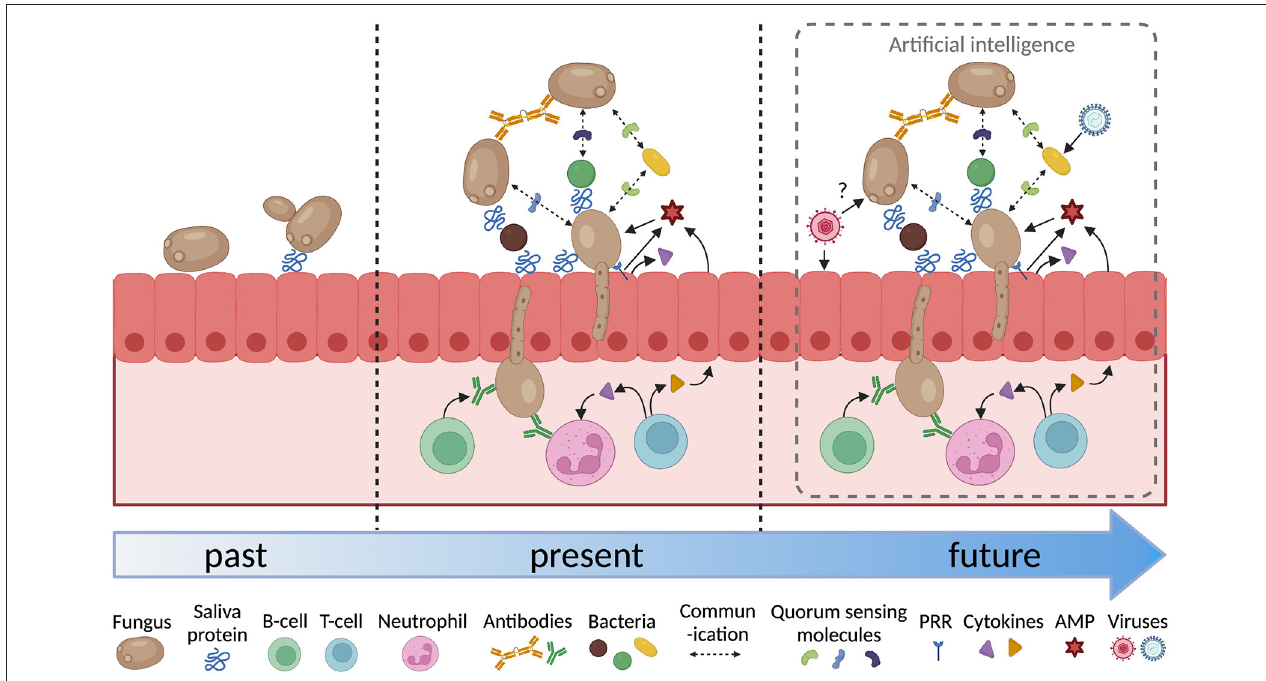
FIGURE 1 | Increasing complexity in the analysis of oral fungal/microbial/host interactions. PRR, pattern recognition receptor; AMP, antimicrobial peptide. Figure created with